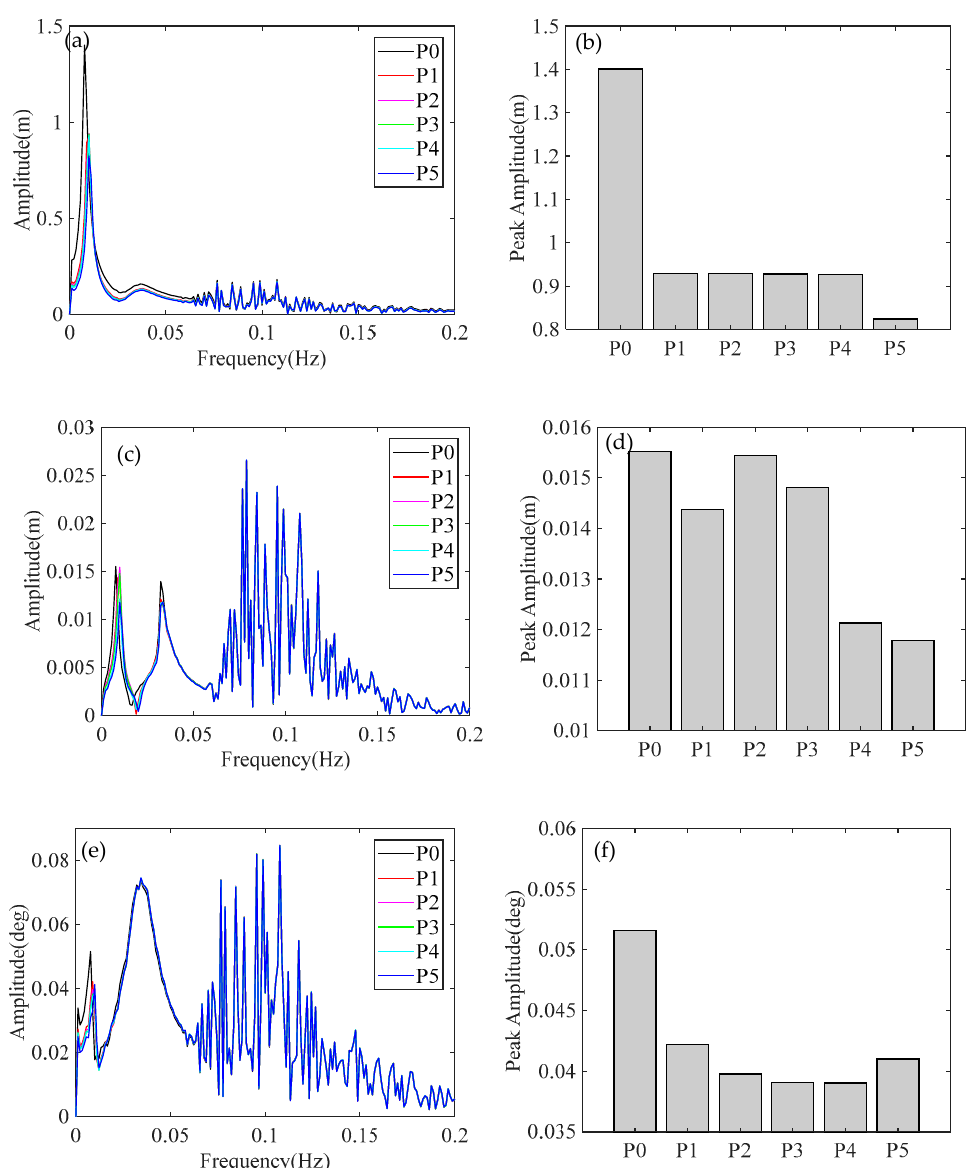
Figure 12. Frequency domain amplitude at load case 5 for ( a ) surge, ( c ) heave, and ( e ) pitch, and the peak amplitudes for ( b ) surge, ( d ) heave, and ( f ) pitch.